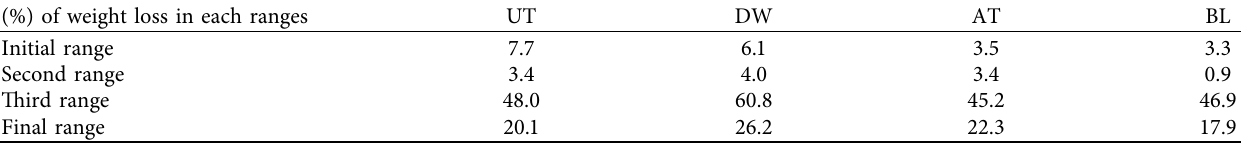
Table 5: Weight loss of the samples at each